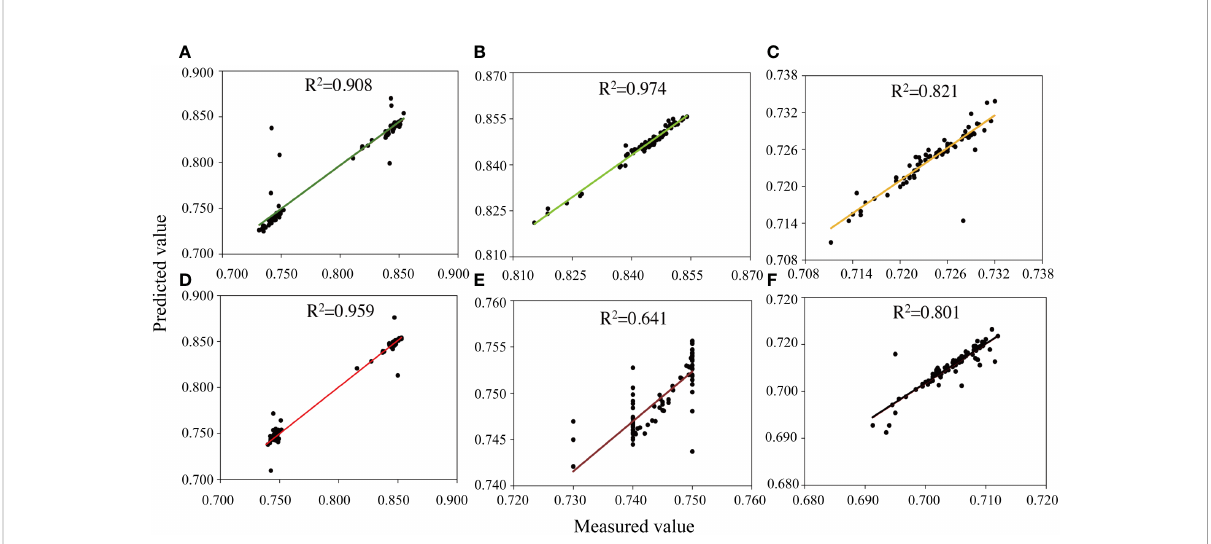
FIGURE 8 F /F v m predicted and measured values from the test data set under (A canopy characteristics input by each model is from (A, D) 6 July 2021 ( fl owering stage), (B, E) 14 August 2021 (boll setting stage), and (C, F) 17 September 2021 (boll opening